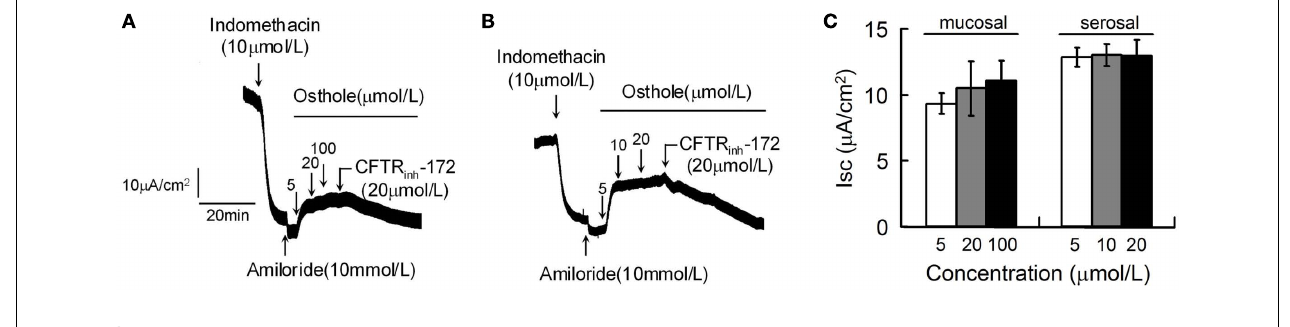
Where indicated, osthole and CFTR inh -172 was added. Osthole was added to mucosal (A) and serosal (B) sides separately. (C)